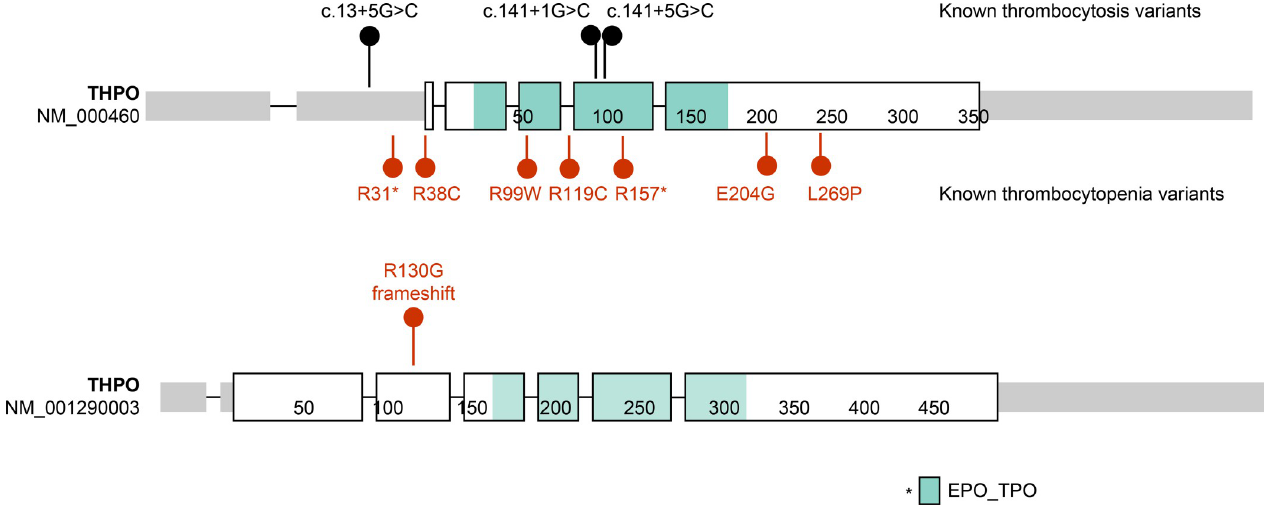
Fig 6. Reference THPO gene sequence of NM_000460 and NM_001290003. Known variants of the THPO gene sorted by variant type at NM_000460. THPO variants found in hereditary thrombocytopenia and thrombocytosis are indicated in red dots and black points, respectively. The reference sequence NM_001290003 contains THPO :c.388_389delAG, p. R130G. Image created using ProteinPaint, which is the protein-based visualization tool created at St. Jude. � Green area indicates the coding region of erythropoietin/thrombopoietin in each lollipop.